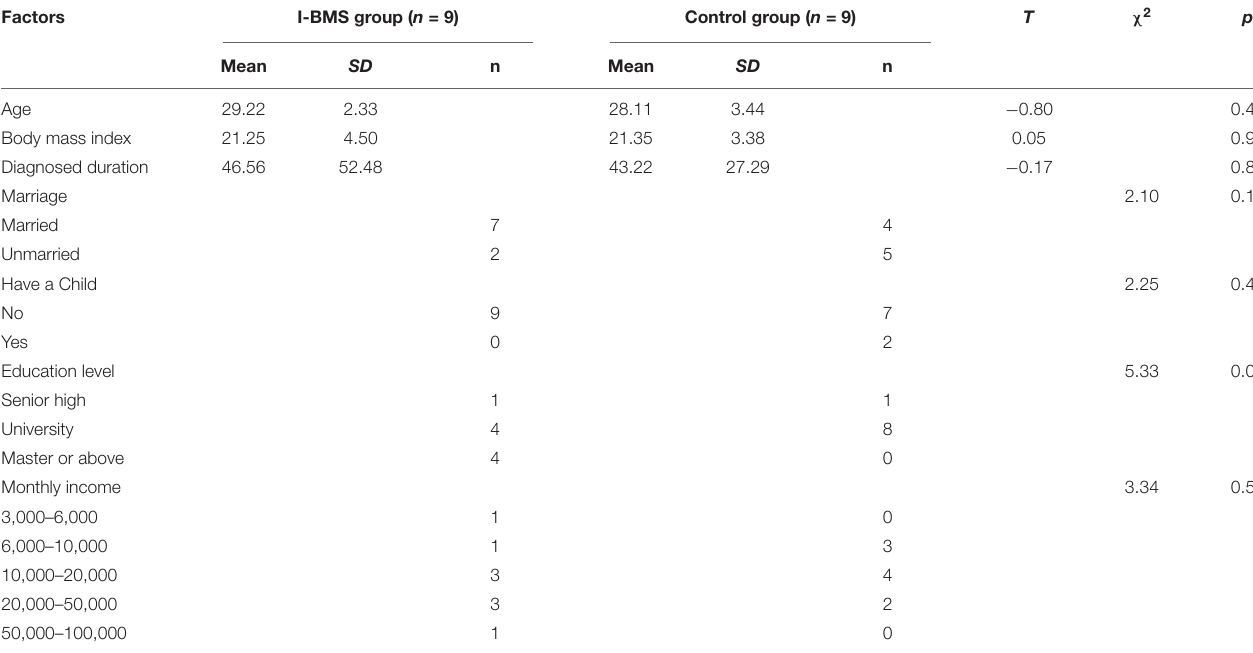
Figure 2 showed the scatterplot matrix of associations between standardized residuals of changes in each outcome, which presented the mind-body associations and the